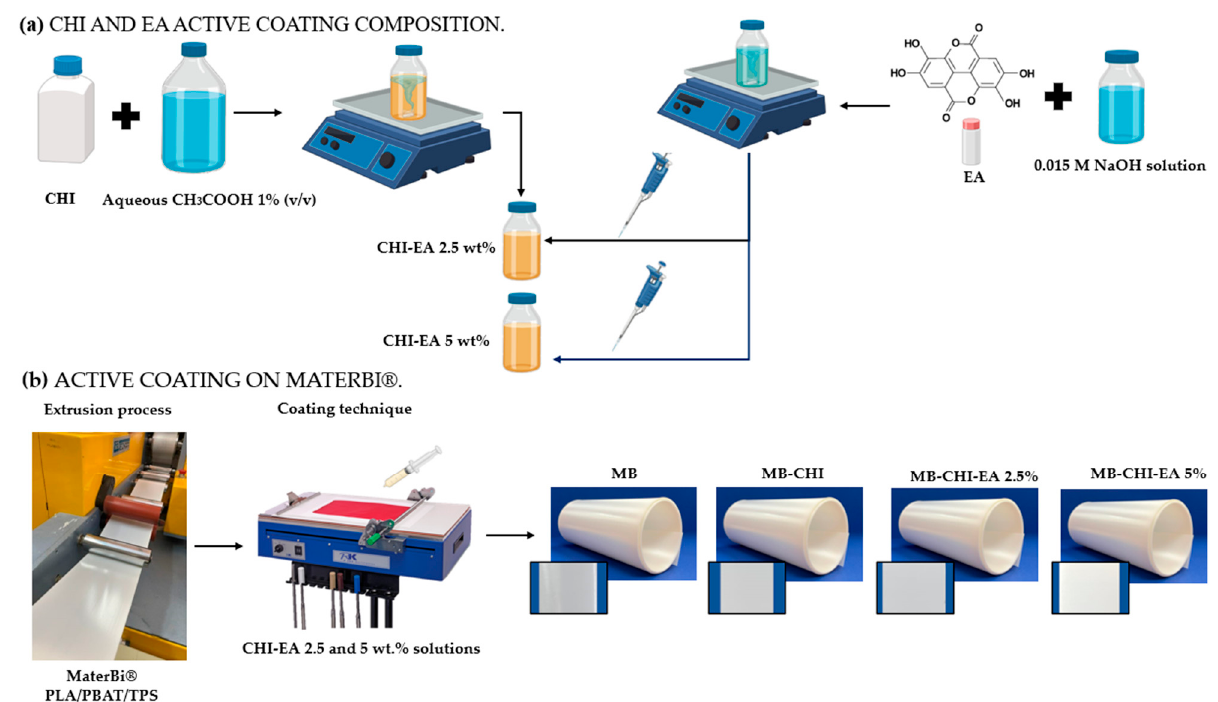
Figure 1. Schematic diagram of the process of obtaining active commercial biopolymers ( a ) coating composition and ( b ) incorporation active coating.